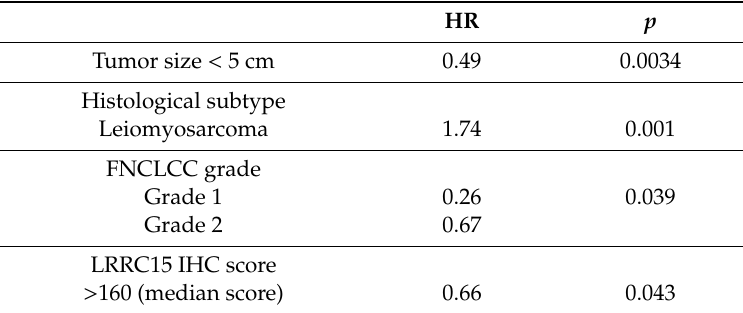
Table 2. Multivariate analysis for metastasis-free survival ( n = 425).